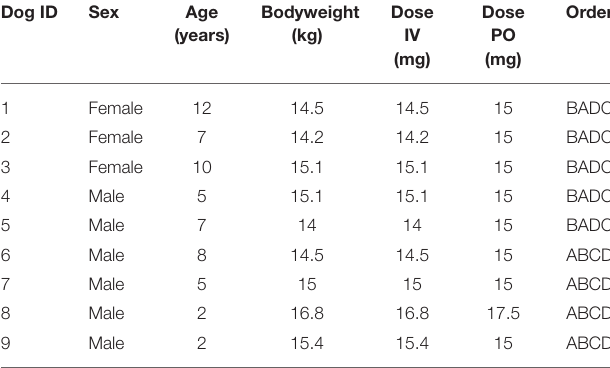
TABLE 1 | Population characteristics, prednisolone doses and treatment